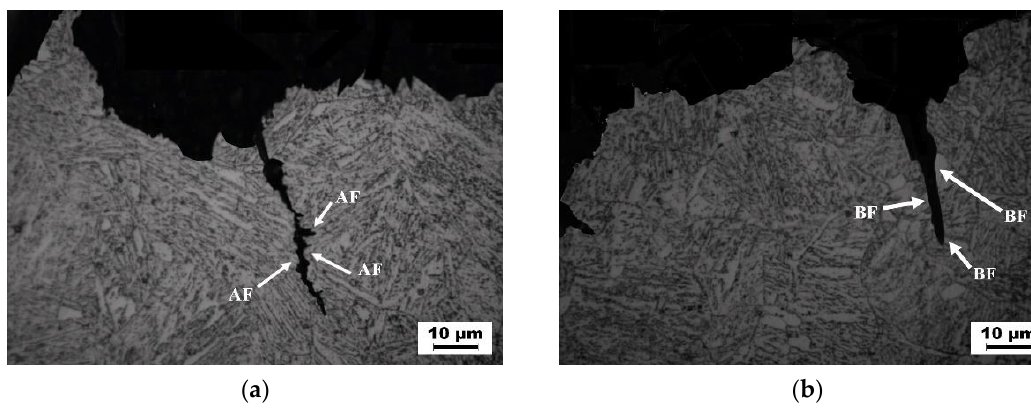
Figure 9. Crack extension of impact fracture of weld metal. ( a ) across the AF ( b ) across the BF.